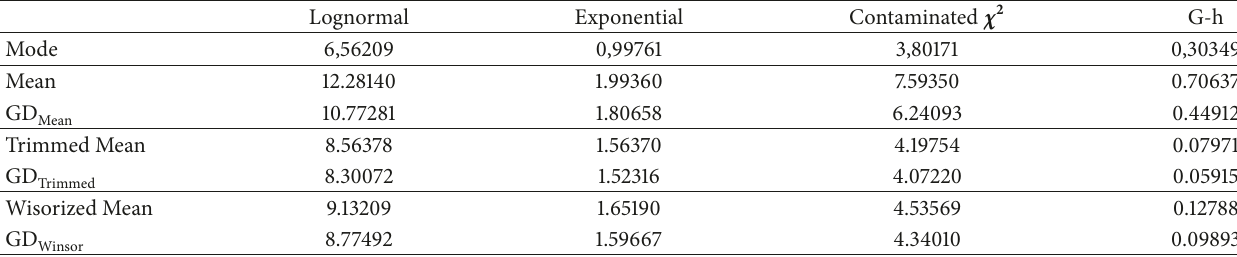
Table 2: The estimates of location for different distributions with 20 points without noise. Respectively, we have lognormal distribution 𝑥 = 2 and 𝑠 = 1 parameters; exponential distribution 𝜆 = 2 parameter; contaminated 𝜒 2 𝑘 1 = 4 , 𝑘 2 = 40 , and 𝜀 = 0.9 parameters; G-h distribution 𝑔 = 0.5 and ℎ = 0.5 parameters.